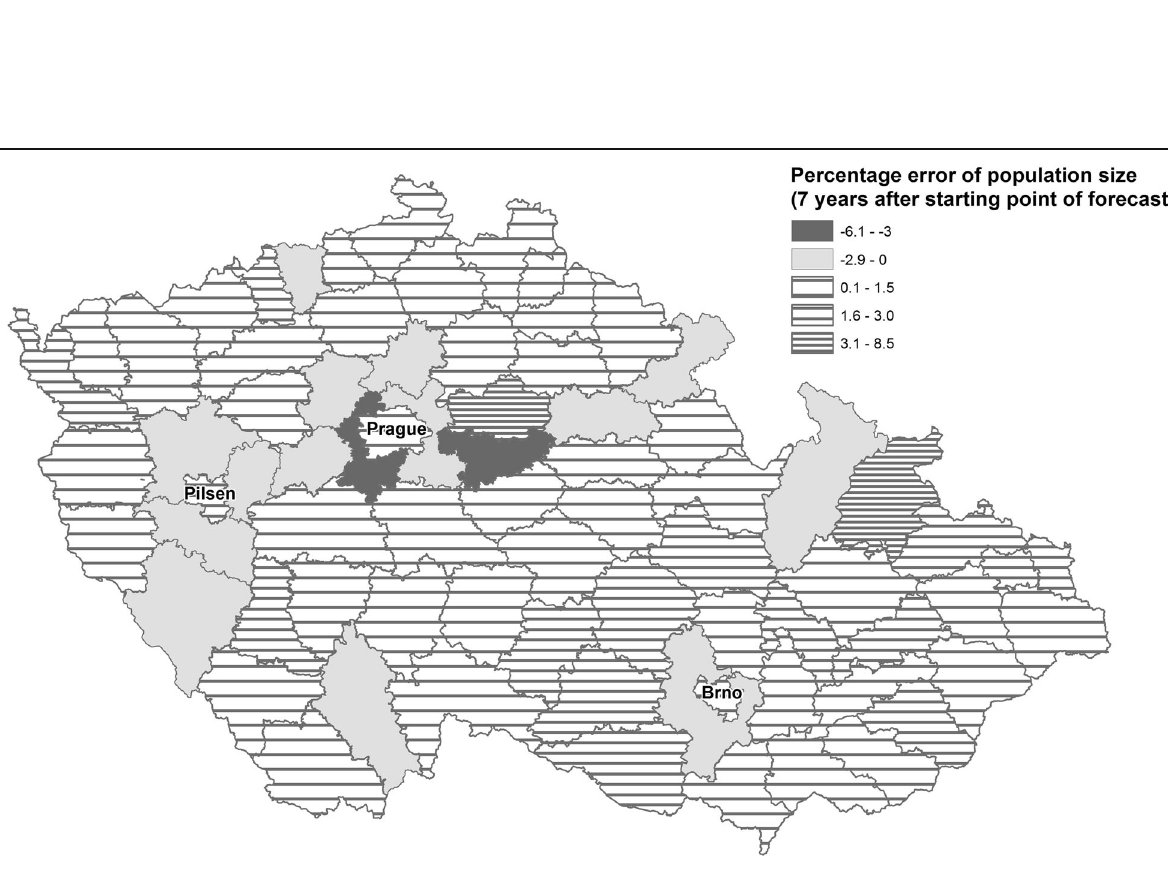
Fig. 4 Percentage error of population size in districts of the Czech Republic. Source: [15], authors ’ calculations. Note: districts existing in the 1990s, calculated for year 2000 (7 years after